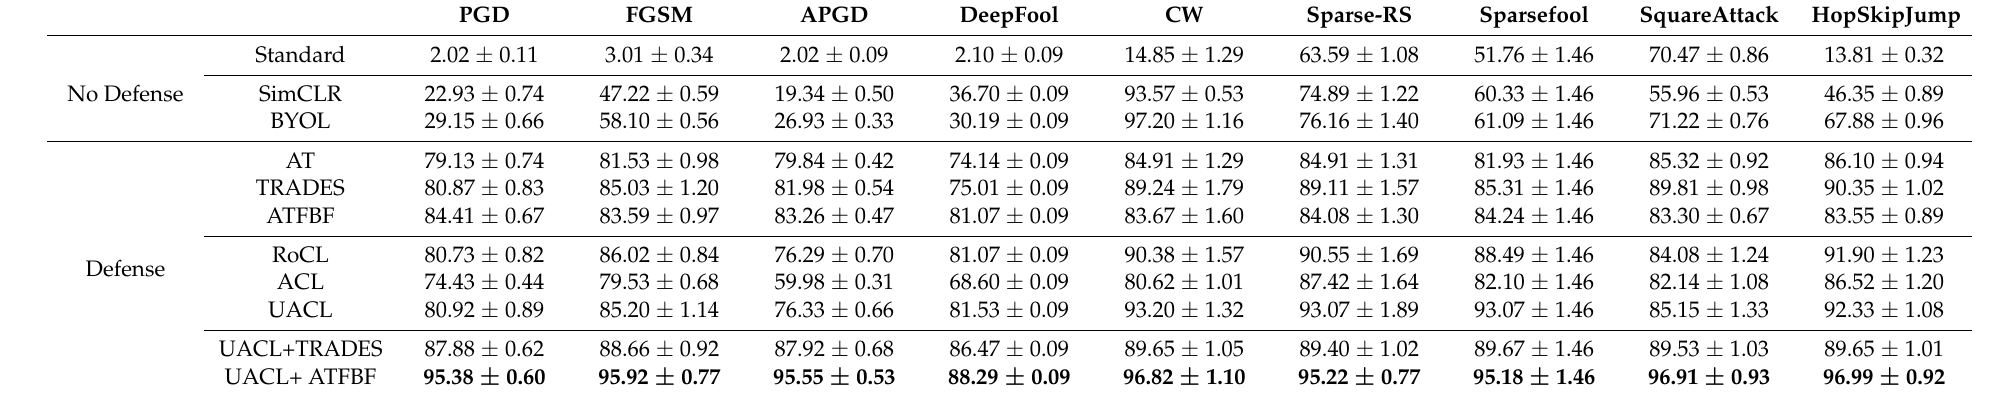
Table 11. Classification accuracy of models (ResNet18) with no-defense or defense methods against different kinds of adversarial attack in MSTAR dataset. PGD FGSM APGD DeepFool CW Sparse-RS Sparsefool SquareAttack HopSkipJump